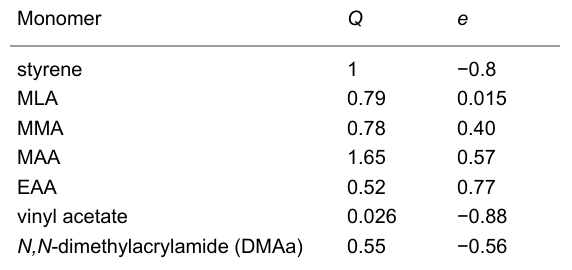
Table 2: Alfrey–Price Q and e values of various monomers with styrene as reference system. Monomer